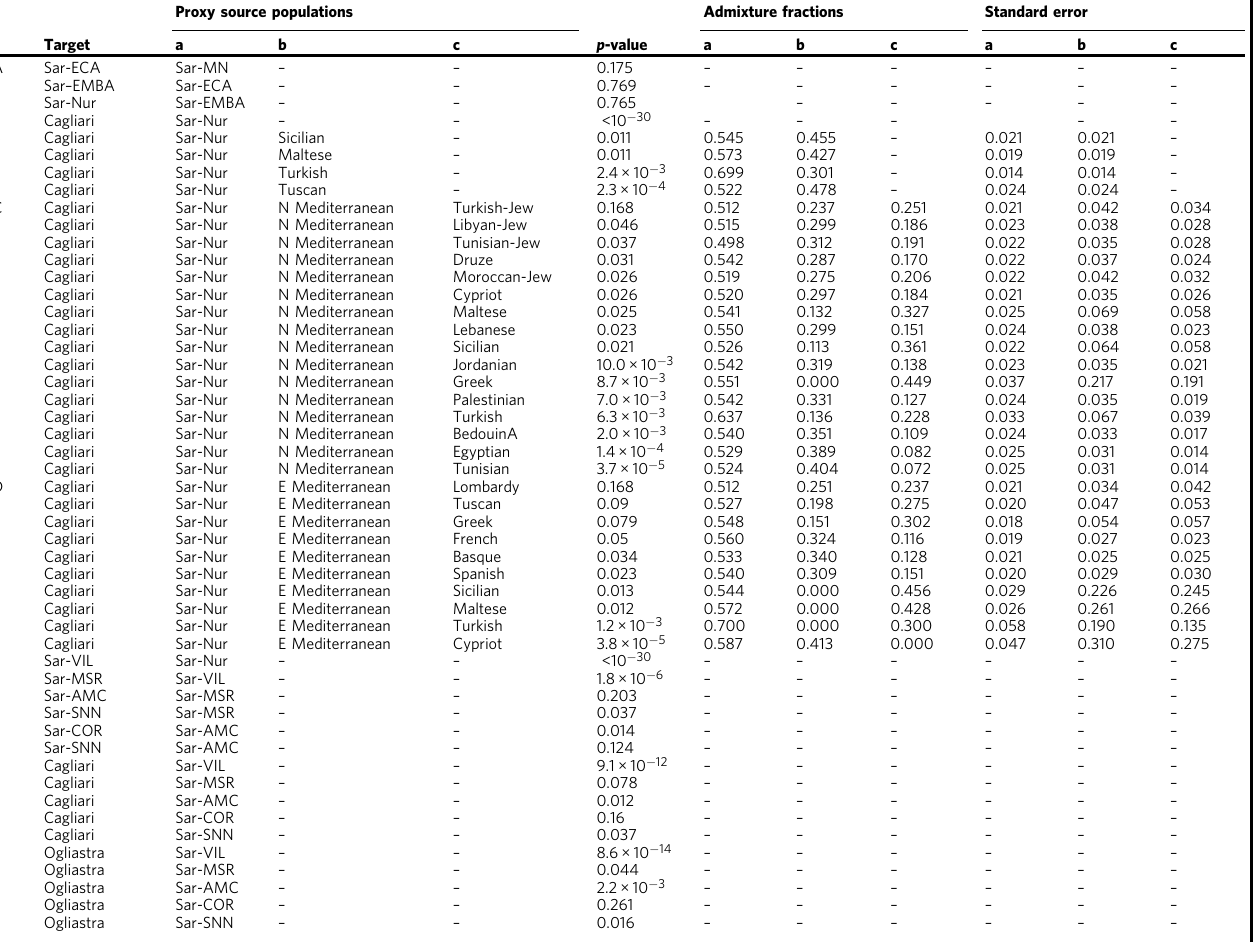
Table 2 Results from fi tting models of admixture with qpAdm and Sardinian aDNA as